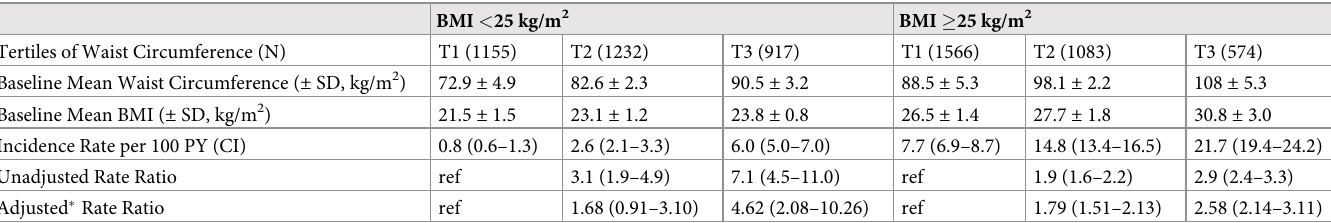
Table 5. Baseline waist circumference and the risk of NAFLD in lean and non-lean